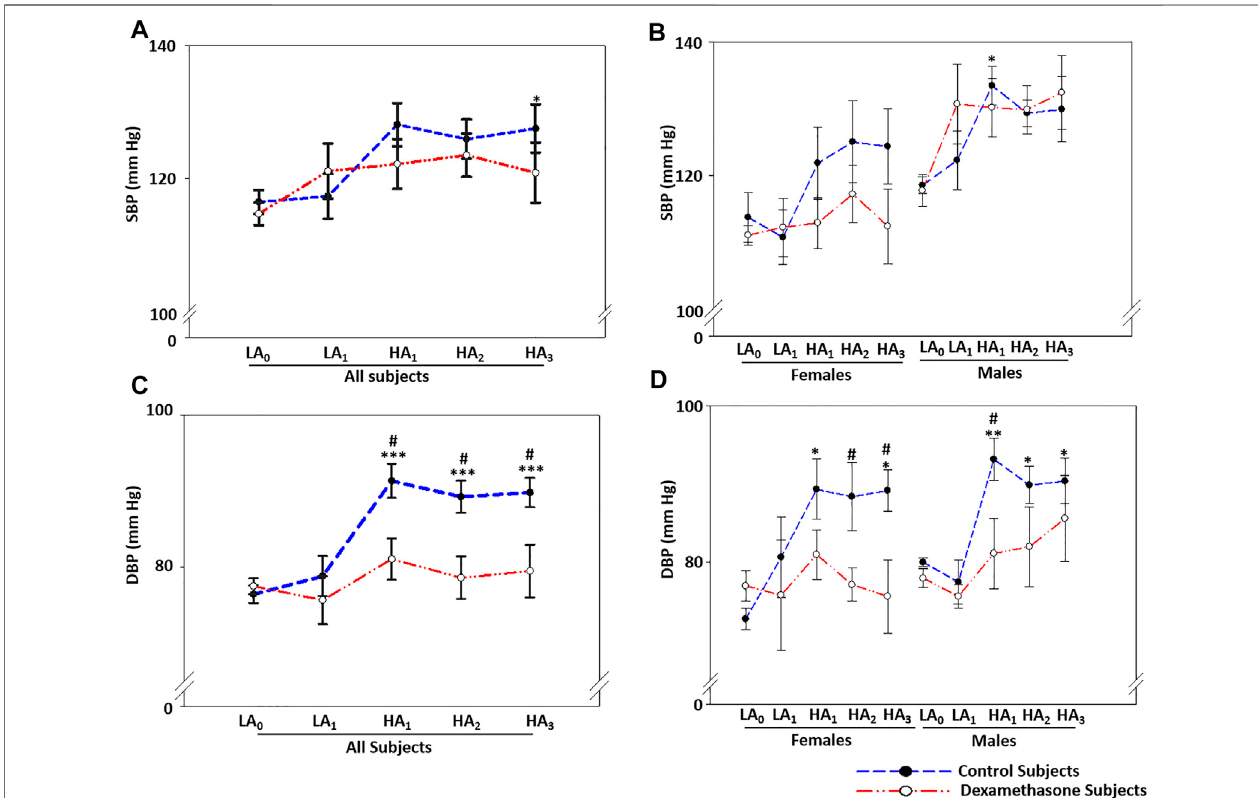
FIGURE1| DexamethasoneattenuatedBPelevation at HAwith agreaterprotectiontowomen. (A) Dexamethasoneattenuated SBP-elevationby~3.2 mmHg for 3 days at HA compared to the elevation in the control groups. (B) Dexamethasone attenuated SBP-elevation in women by ~7.0 mmHg, while it did not control SBP in men. (C) Dexamethasone attenuated DBP-elevation by ~10.8 mmHg when compared to the elevation in the control groups. (D) Dexamethasone controlled DBP- elevation at HA in women by ~15.4 mmHg and in men by ~6.9 mmHg compared to elevations in the respective control groups. Data are presented as mean ± SE and are compared by one-way ANOVA. */ # p < 0.05, **/ ## p < 0.01, and ***/ ### p < 0.001 were considered statistically signi fi cant. * represents signi fi cance within each groupcomparedtorespectivecontrolatday0 atLA,while # representssigni fi